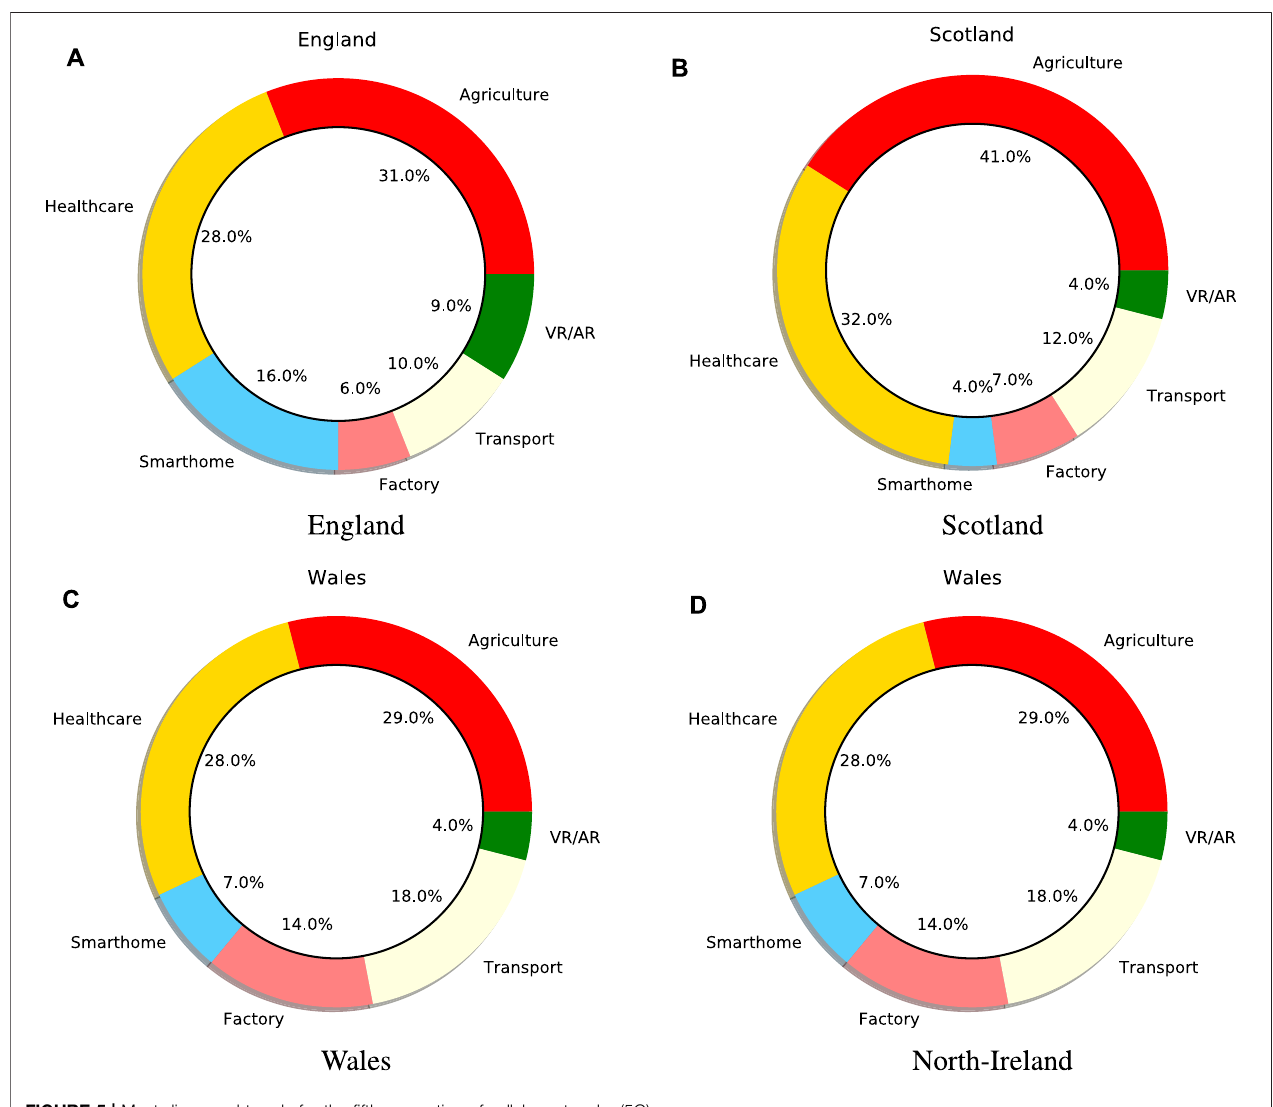
FIGURE 5 | Most discussed trends for the fi fth generation of cellular networks